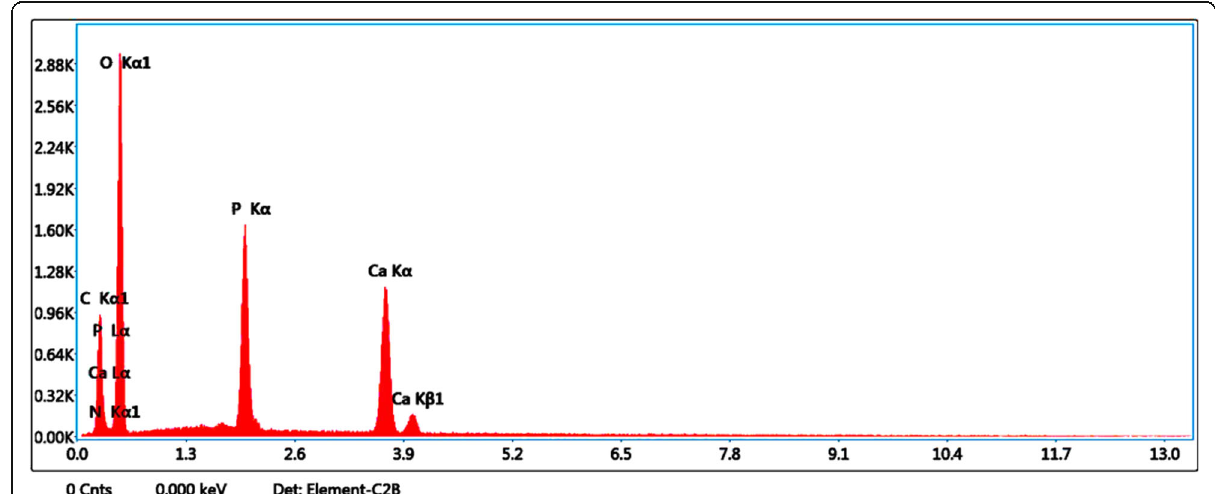
Fig. 12 EDAX spectrum of 50 mg A. marmelos added CHPD